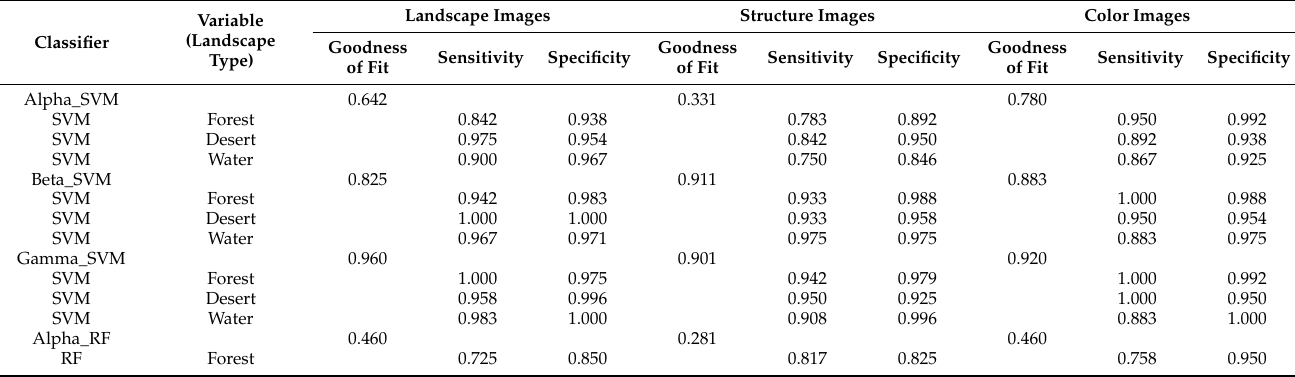
Table A2. The goodness of fit, specificity, and sensitivity of different classifiers for different scenarios.